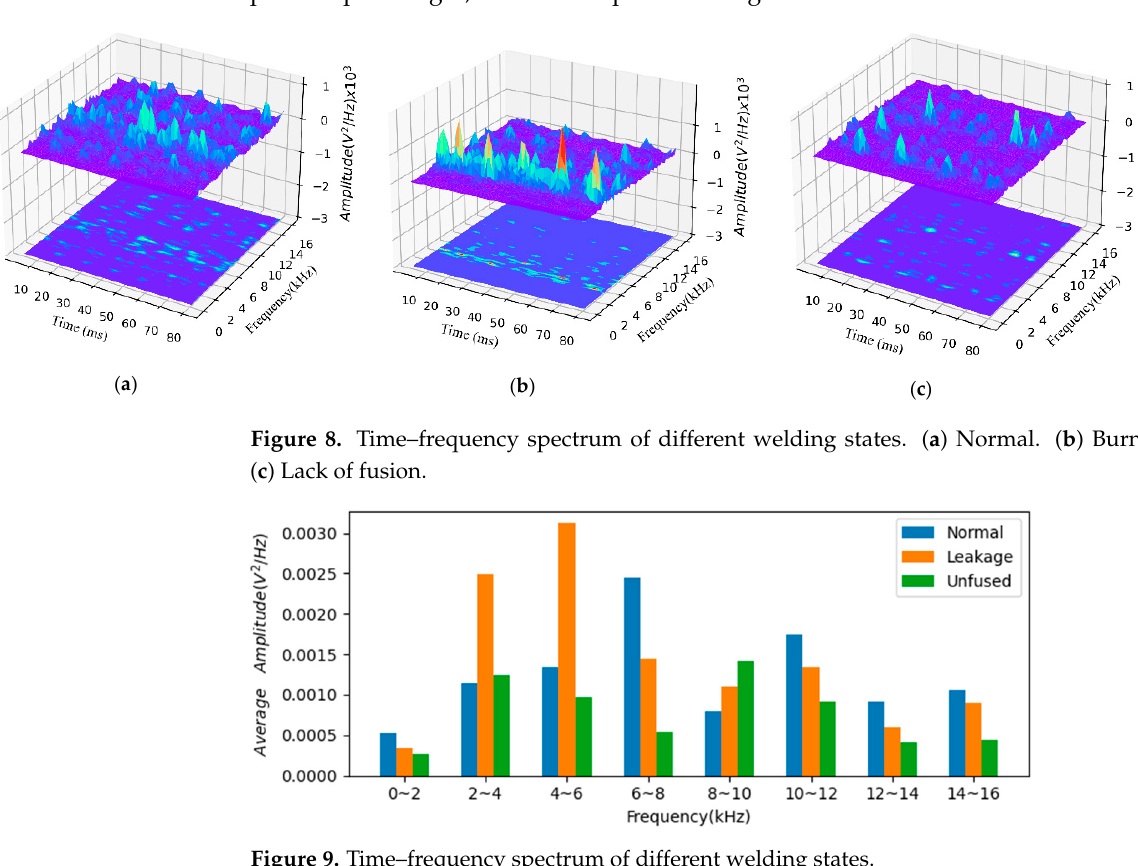
Figure 9. Time–frequency spectrum of different welding